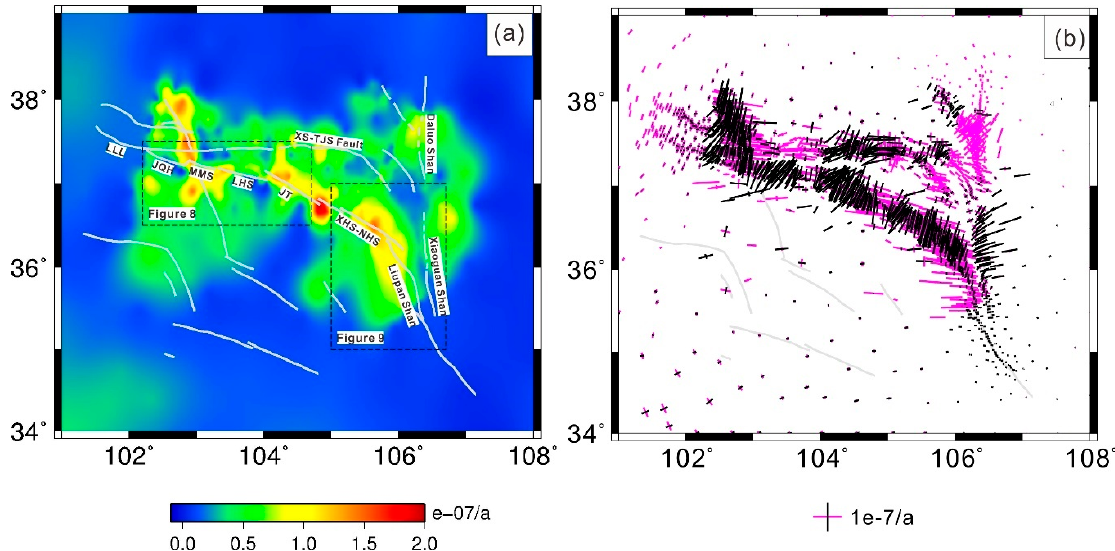
Figure 7. Results inverted jointly by InSAR and GPS for the northeastern margin of the Tibetan Plateau. ( a ) The horizontal strain rate field: the magnitude of second invariant of the strain rate tensor. The black dashed boxes show the areas for the Figure 8 and Figure 9. LLL: Leng Long Ling, JQH: Jing Qiang He, MMS: Maomao Shan, LHS: Laohu Shan, JT: Jing Tai, XHS-NHS: Xihua Shan-Nanhua Shan, XS-TJS: Xiang Shan-Tianjing Shan. ( b ) The principal compressive/tensile stress direction map. The short black lines are for compressive stress and the pink lines are for the tensile stress.